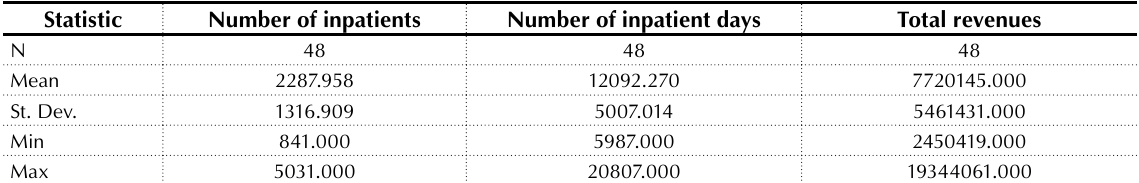
Table 2. Descriptive statistics of output